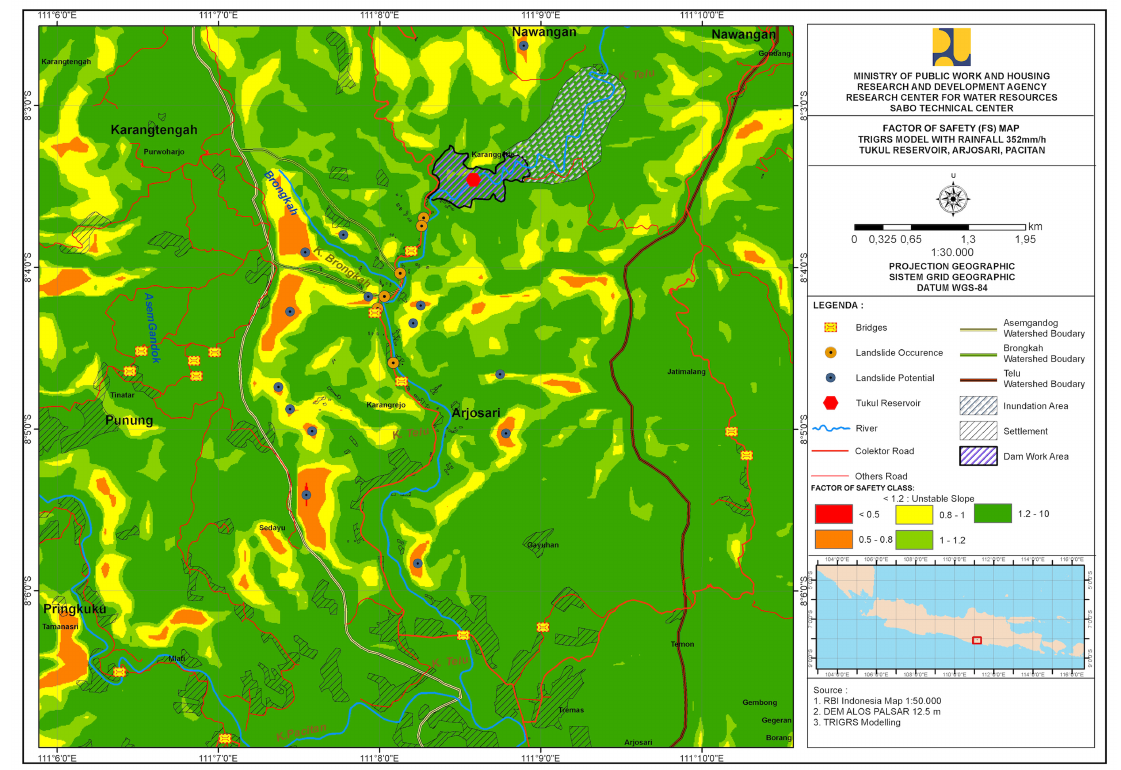
Figure 8. A factor of safety map for Pacitan region simulated using the Transient Rainfall Infiltration and Grid-based Regional Slope-stability (TRIGRS) model on 28 November